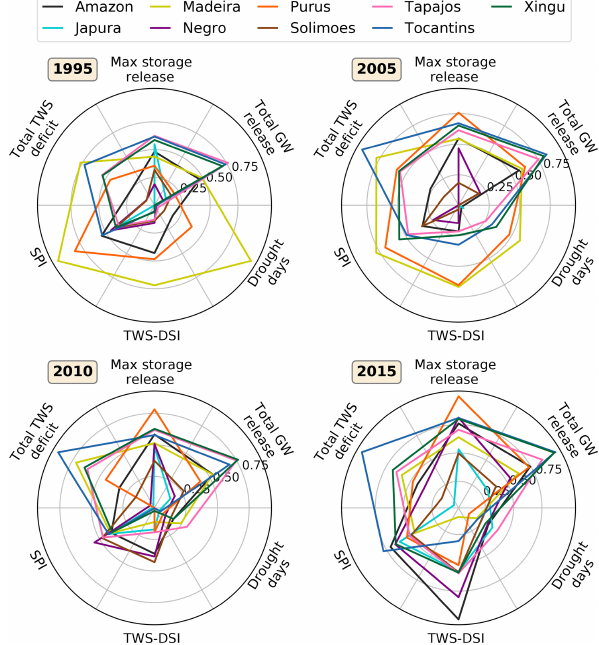
Figure 10. Intercomparison and comprehensive characterization of the severe drought events during the study period in the Amazon River basin and its sub-basins. Color coding in each subplot rep- resents individual river basins. Note that all variables are basin av- erages normalized (0–1) for each variable over all drought years. The bottom half of the variables in the figure are drought in- dices representing different types of droughts: TWS-DSI denotes TWS drought severity index (Sect. 2.7), SPI (Standardized Pre- cipitation Index) represents meteorological drought severity, and “drought days” represents hydrological drought severity in the basin (Sect. 2.6). The top half of the variables quantify the water deficit in terms of total TWS deficit (cumulative PET-P), water supply as the TWS release (max storage release), and the groundwater contribu- tion of TWS release (total GW